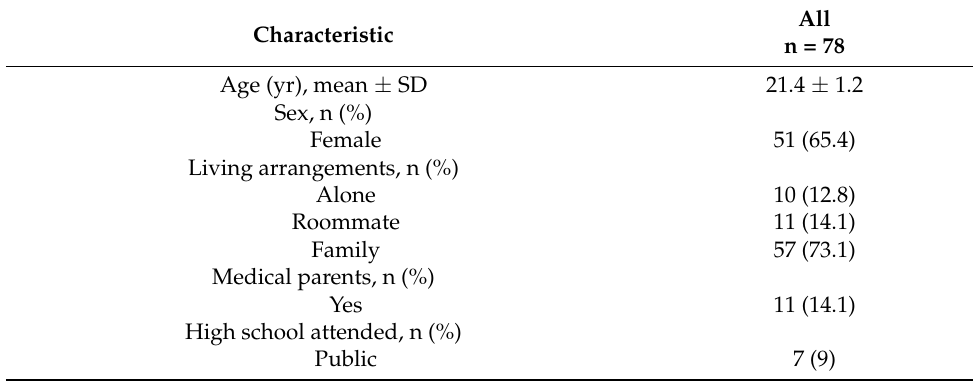
Table 2. Baseline characteristics of the USFQ’s Keys to Academic Success Program